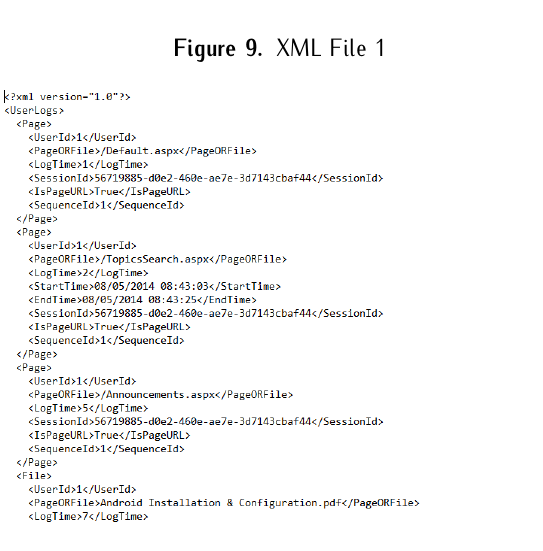
Figure 10. XML File 2